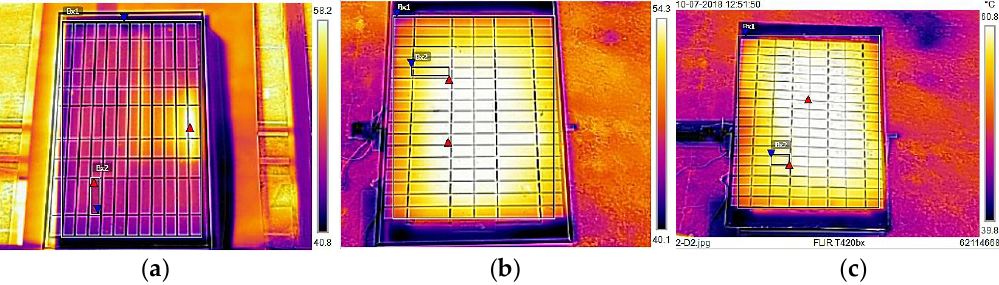
Figure 6. Modified thermal image of the PV panel under ΔT°C=15°C : ( a ) healthy, ( b ) EVA discolouring defect, ( c ) delamination defect. Energies 2020 , 13 , x FOR PEER REVIEW